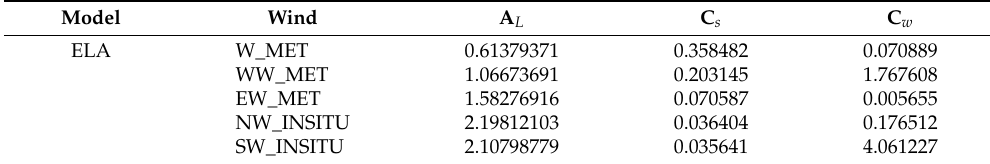
Table A3. Coefficients of ELA Equation (A3) by wind